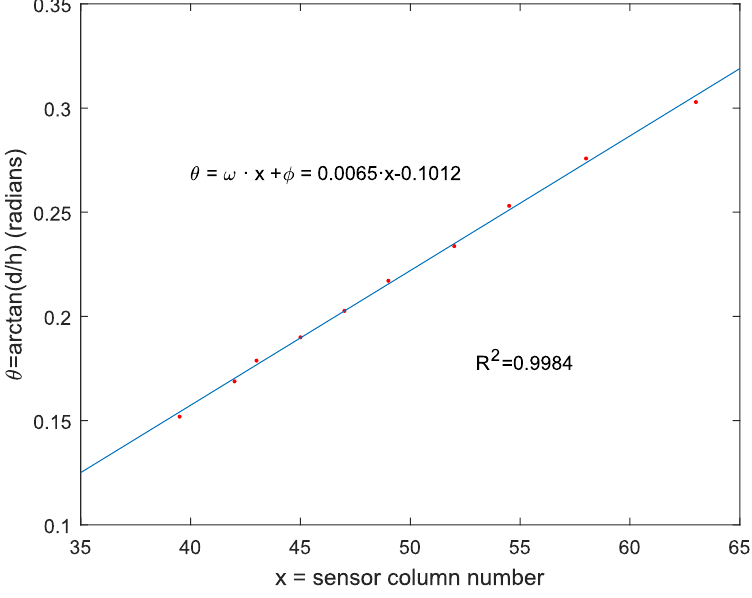
Figure 8. Least squares adjustment of sensor